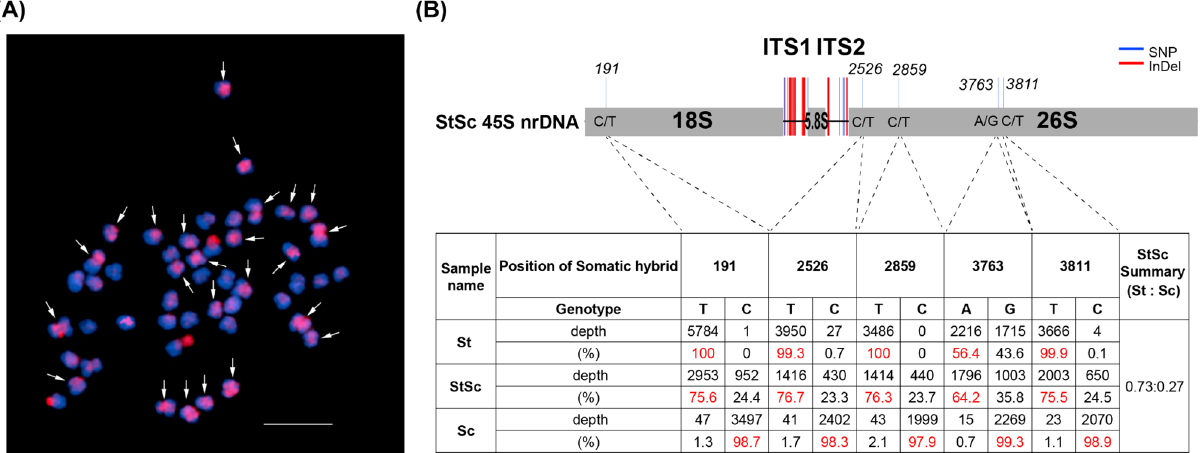
Figure 3. Detection of nuclear genome fusion in somatic hybrid. ( A ) GISH analysis of somatic hybrid (HA06-1 clone) using S. tuberosum specific-probes. The red signal of 24 arrows indicates the S. commersonii nuclear